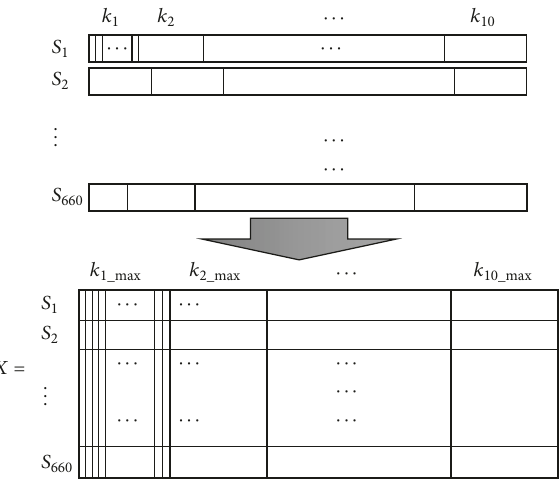
Figure 4: Dimensionality reduction of the feature matrix 𝑋 , containing training subjects from the ADNI dataset, used to train the